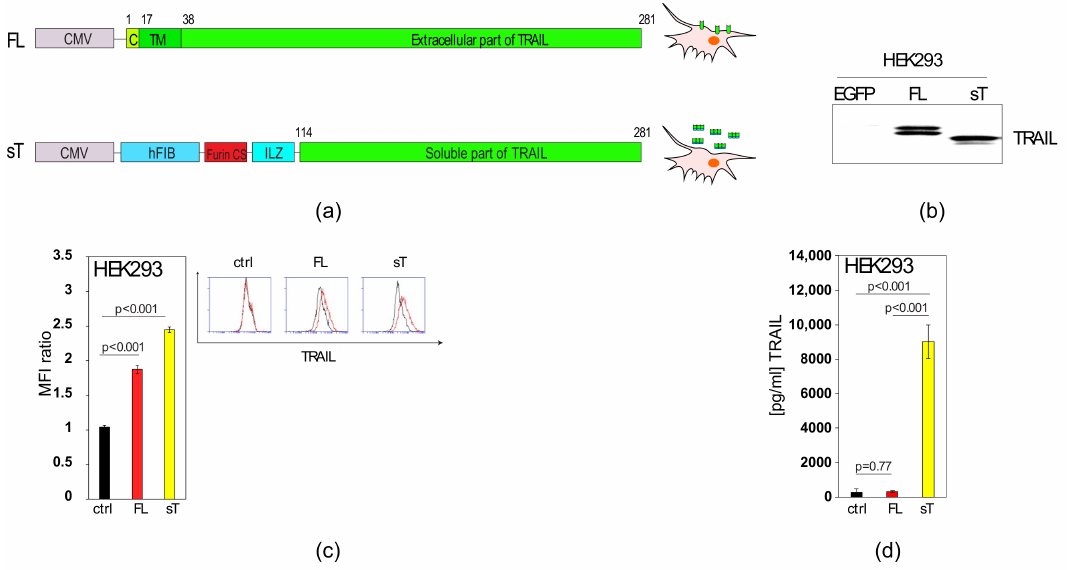
Figure 1. FL-TRAIL and sTRAIL are expressed in HEK293 cells, but only sTRAIL is secreted into the supernatant. ( a ) Schematic depiction of full length, membrane bound TRAIL (FL) and soluble TRAIL (sT) expression cassettes including depiction of the localisation of the two TRAIL forms when expressed in cells. The full-length version is the TRAIL cDNA corresponding to aa1-aa281 containing a cytoplasmic part (C), transmembrane region (TM) and the extracellular domain. The sTRAIL construct consists of a hFIB heterologous signal peptide, a Furin cleavage site (Furin CS), an Isoleucine Zipper (ILZ) and the sTRAIL part from aa114–281. Both constructs are under the control of the CMV promoter within pcDNA3 expression plasmids or adenoviral vectors. ( b ) HEK293 cells were transfected with pCDNA3 constructs for EGFP, FL-TRAIL (FL) or sTRAIL (sT). The resulting protein lysates were western blotted and probed with a TRAIL antibody. ( c ) HEK293 cells were transfected with an empty pCDNA3 plasmid (ctrl), as well as constructs for FL-TRAIL (FL) and secreted TRAIL (sT), respectively. The cells were then stained with a TRAIL antibody followed by a secondary antibody carrying a PE fluorescent tag and analysed by flow cytometry. ( d ) HEK293 cells were transfected with expression constructs for FL-TRAIL (FL), secreted TRAIL (sT) or an empty plasmid (ctrl). After 48 h the supernatants were filtered through a 0.45 µ m filter and the resulting filtrates used for a TRAIL ELISA. Values represent mean ±